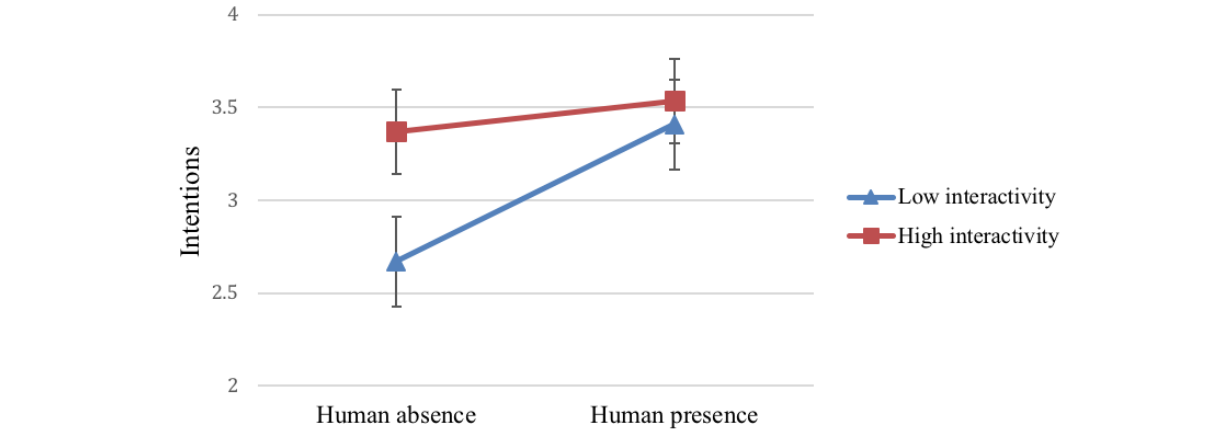
Figure 5. Two-way interaction of human presence and interactivity on intentions.